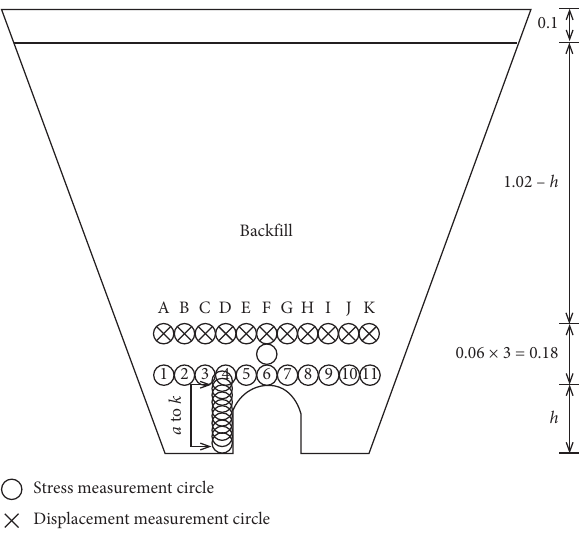
Figure 3: Arrangement of measuring points (unit: